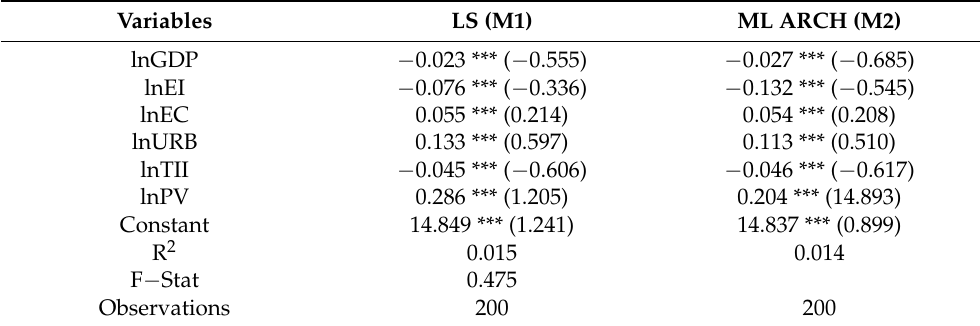
Table 10. Panel estimation results: KZ-Natal CO 2 - eq emissions in the transport sector.